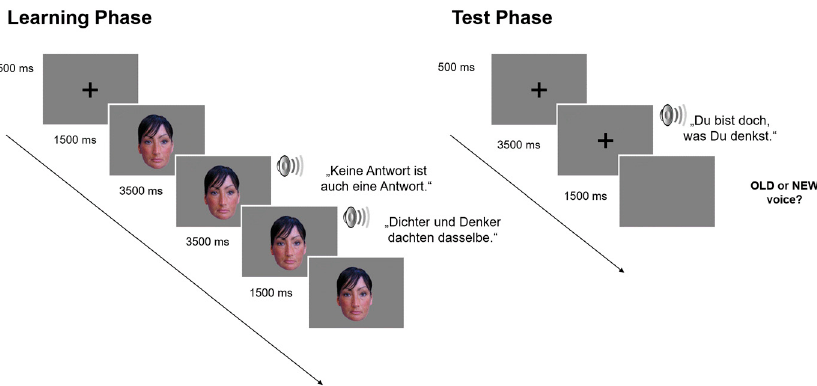
Figure 1. Trial procedure in learning and test phases. In this example, study voices were coupled with distinctive faces.